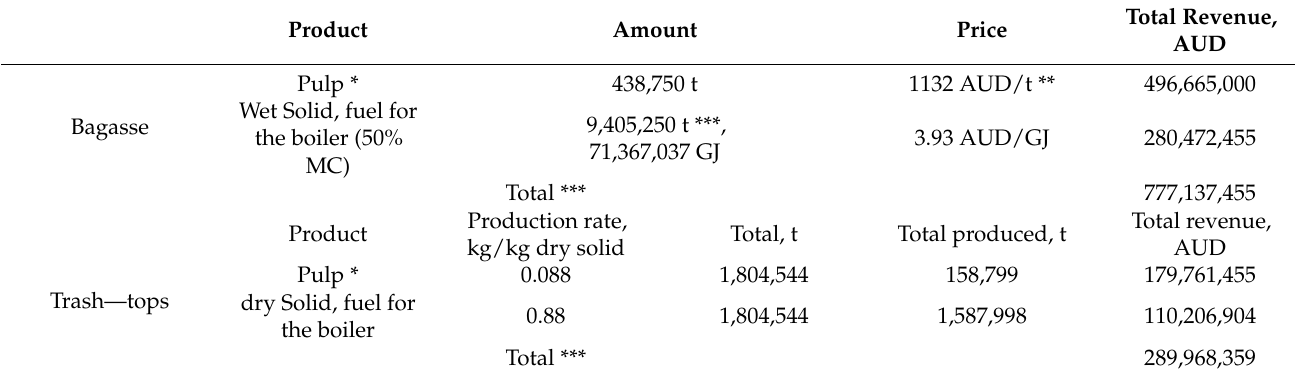
Table 34. Potential gain from pulp production from Bagasse and trash in